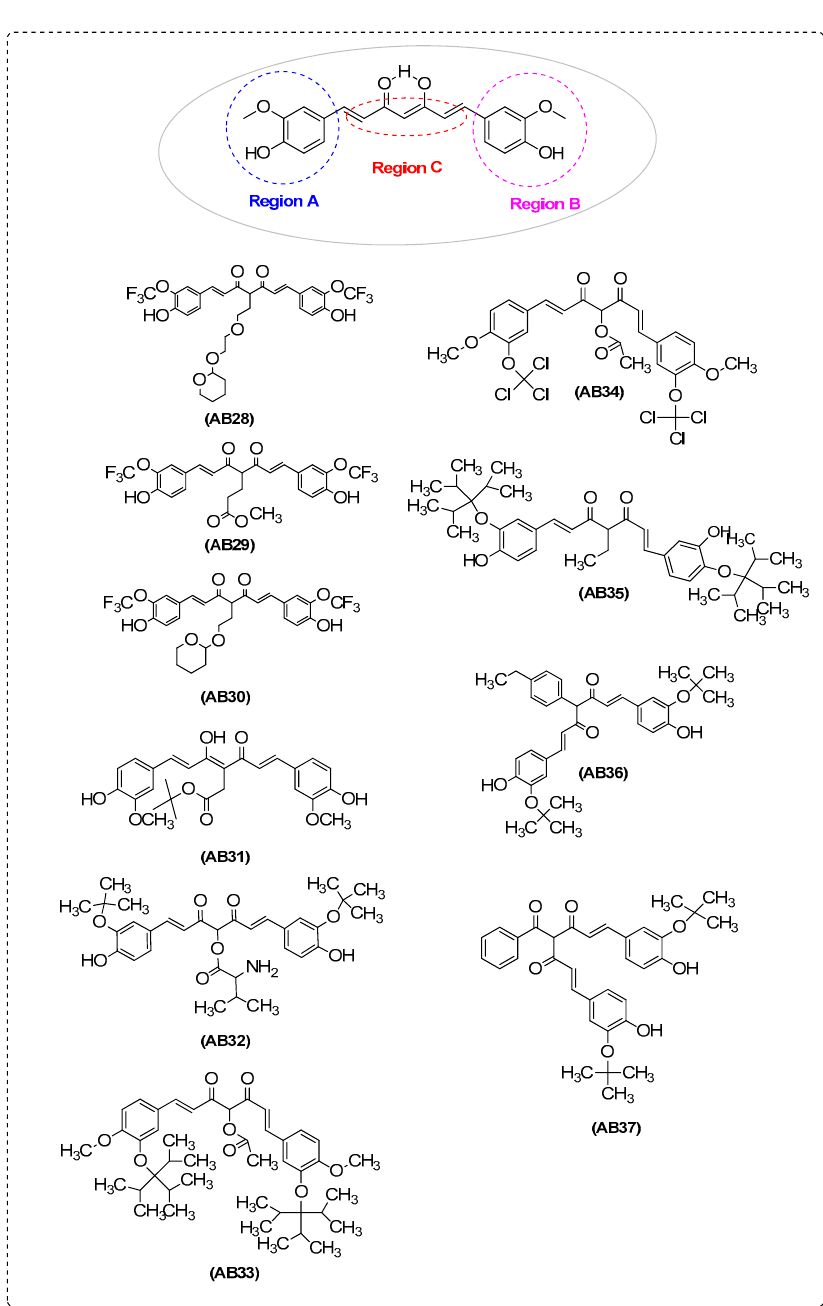
Figure 2. of amyloid- β aggregation. Figure 2. Inhibitors of amyloid- β